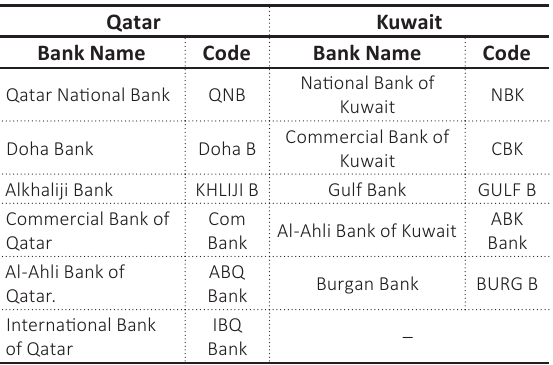
Source: Created by authors.